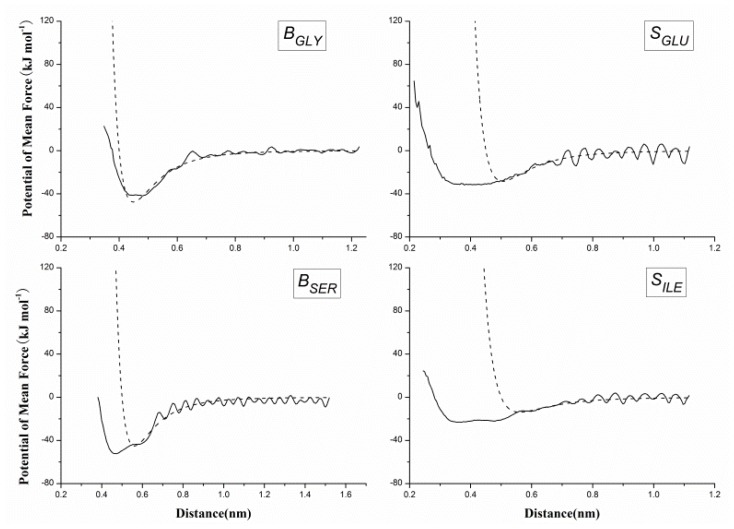
The potential of mean force between non-bonded homo pairs of coarse-grained (CG) beads (BGLY, BSER, SGLU and SILE) against their distance, derived from umbrella sampling method with all-atom simulation (solid curves), and the van der Waals potential by fitting the potential of mean force with the Lennard-Jones function (dash curves).